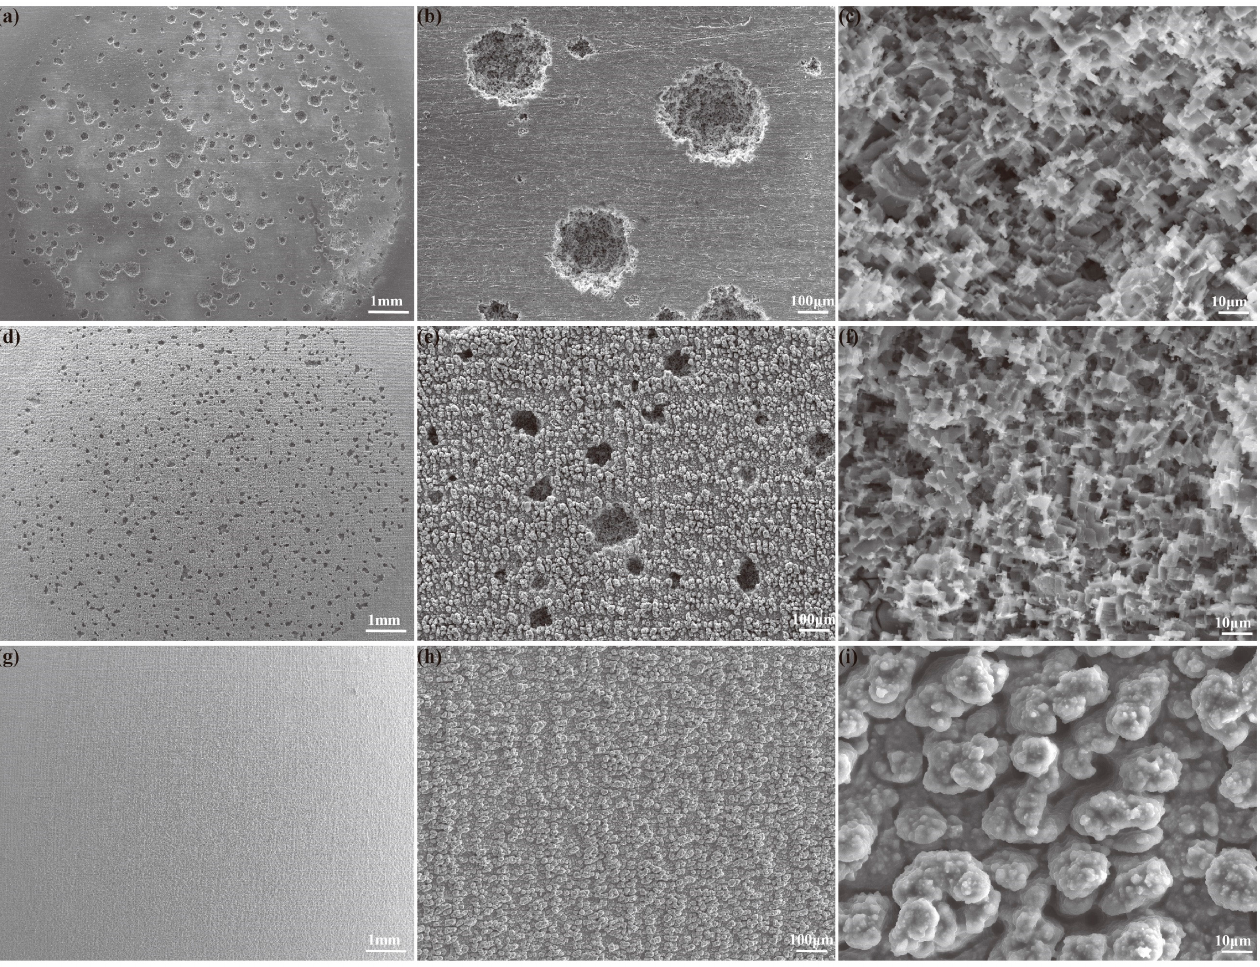
Figure 11. SEM images after electrochemical measurement immersion in simulated seawater for 24 h: ( a – c ) Untreated sample; ( d – f ) SHS; ( g – i ) SLIPS. ( a – c ) Untreated sample; ( d – f ) SHS; ( g – i )